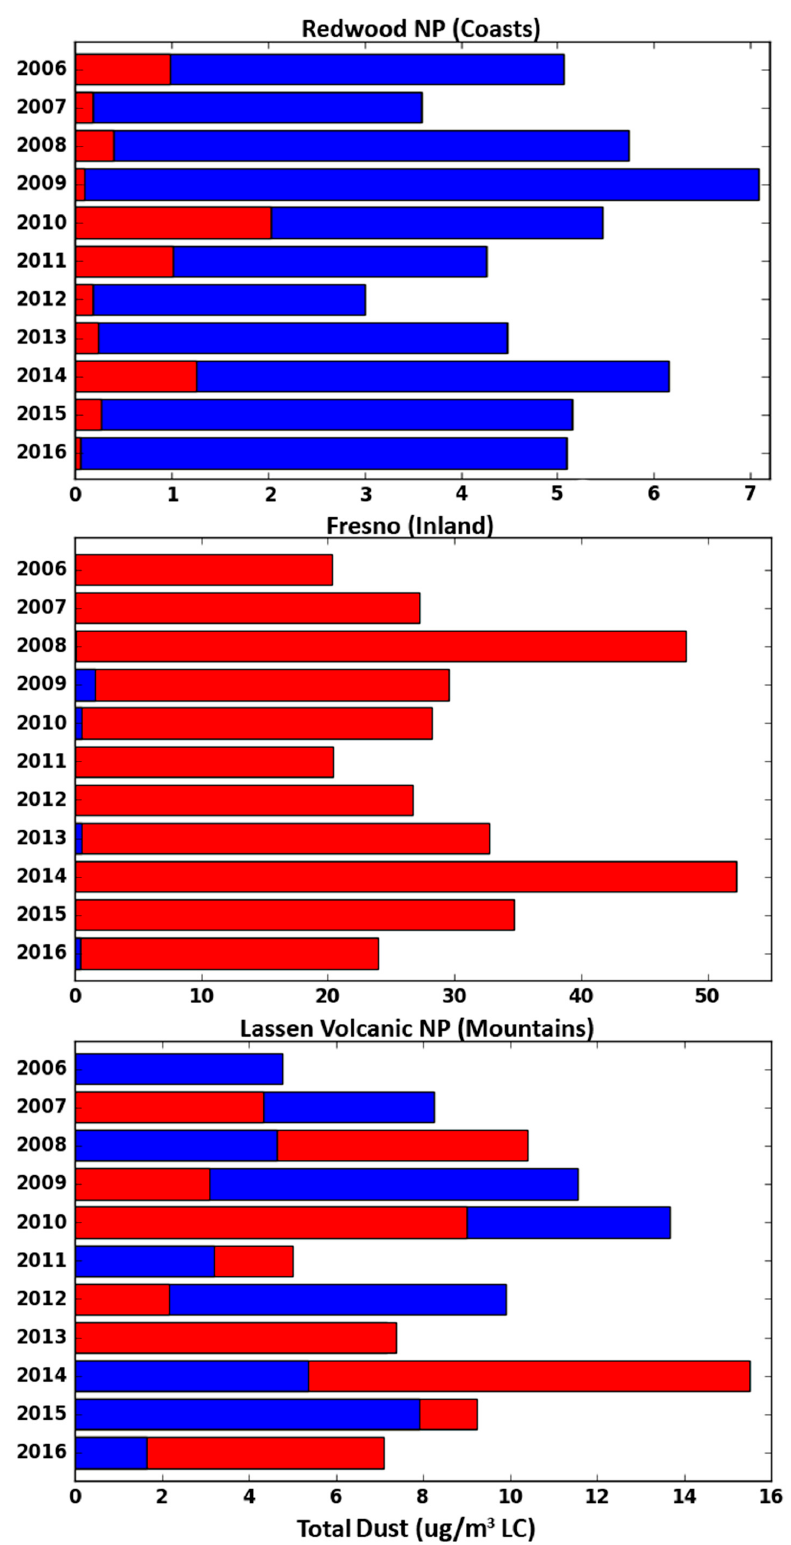
Figure 7. 2006–2016 aerosols. Dust amounts per year were totaled then separated to examine how much of that dust was Asian and non-Asian influenced.